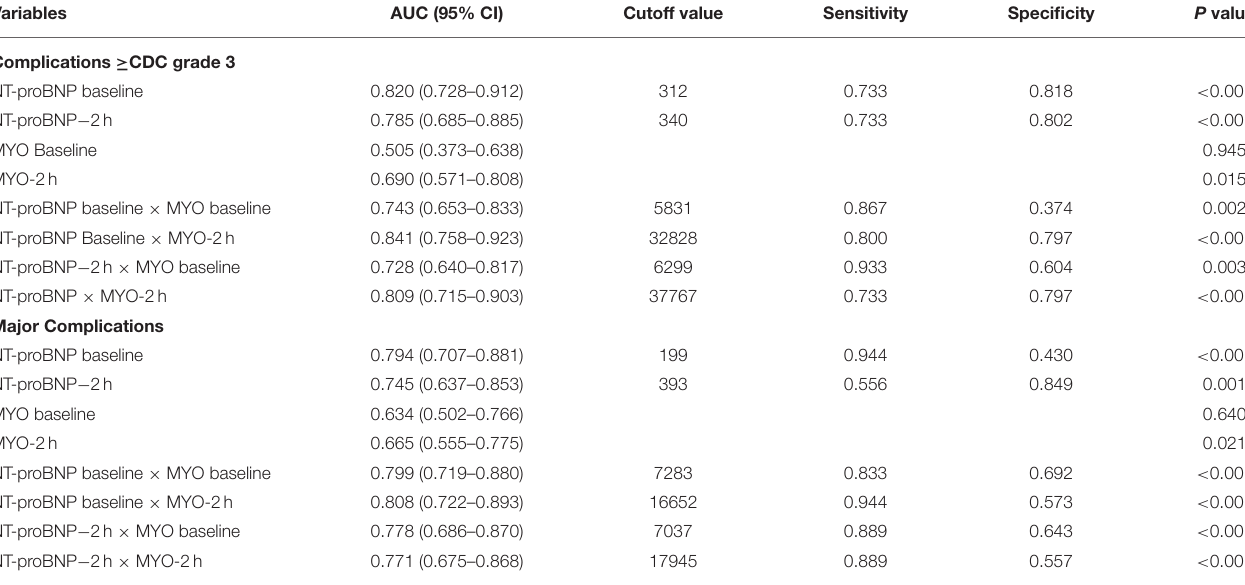
TABLE 3 | Predictive performance of perioperative level of NT-proBNP and MYO for 30-day complications.